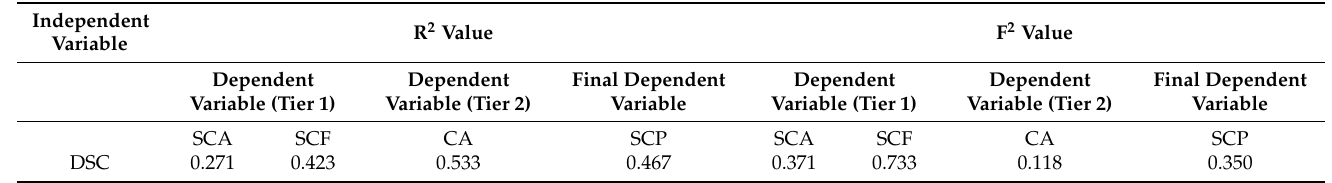
Table 4. Regression and Effect